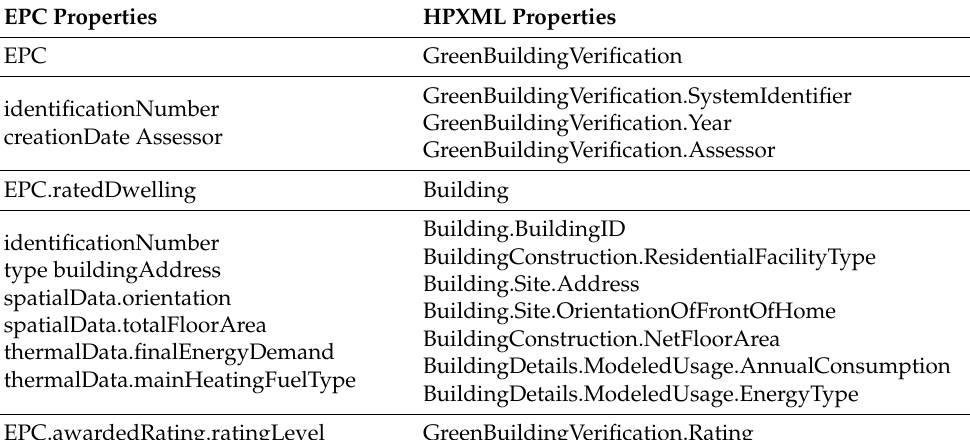
Table 10. EPC properties as HPXML